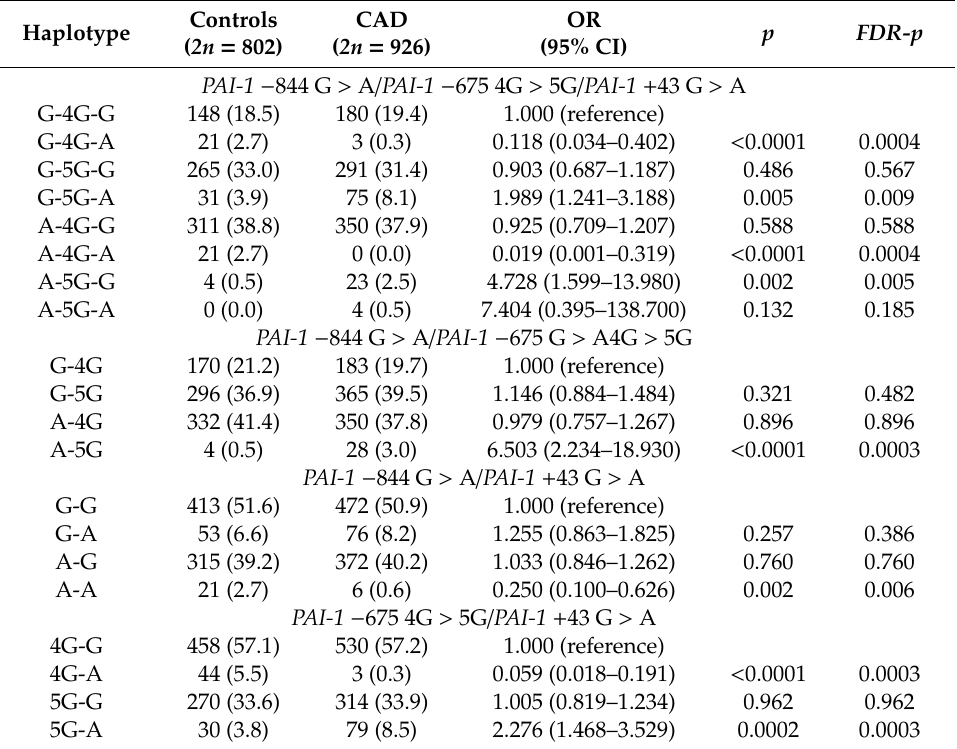
Table 4. Haplotype of the PAI-1 polymorphisms in coronary artery disease.